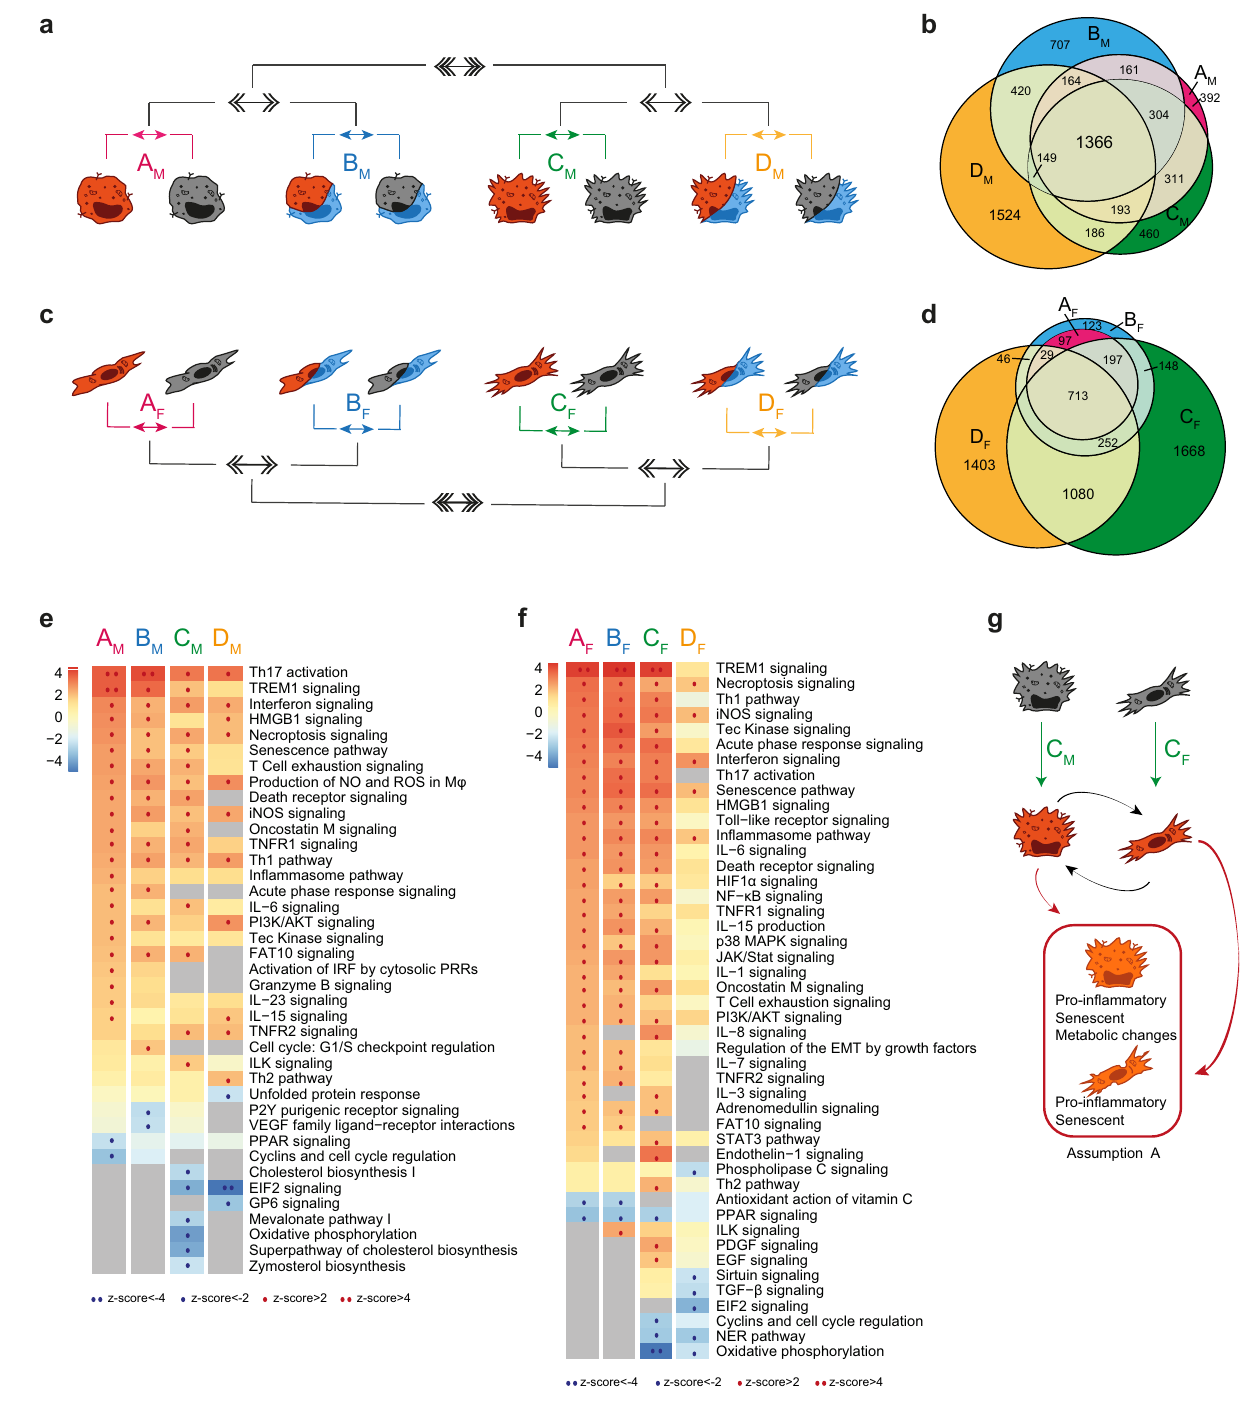
Fig. 2 | Role of in fl ammation on the global biological response. a , c Schematic representation of the multi-level approach to study the effect of in fl ammation on M φ ( a , b , e ) and Fb ( c , d , f ) in different metabolic and culture conditions. 1st level compares LPS+IFN γ stimulated cells to resting cells in four different conditions: normoxicandsingleculture(comparisonA M /A F inpink),hypoxicandsingleculture (B M /B F in blue), normoxic and coculture (C M /C F in green), hypoxic and coculture (D M /D F in yellow). 2nd level (double arrows) compares hypoxic to normoxic treatment (AvsB and CvsD), 3rd level (triple arrows) compares coculture to single culture conditions [(A+B)vs(C+D)]. b , d Venn diagrams show the distribution of